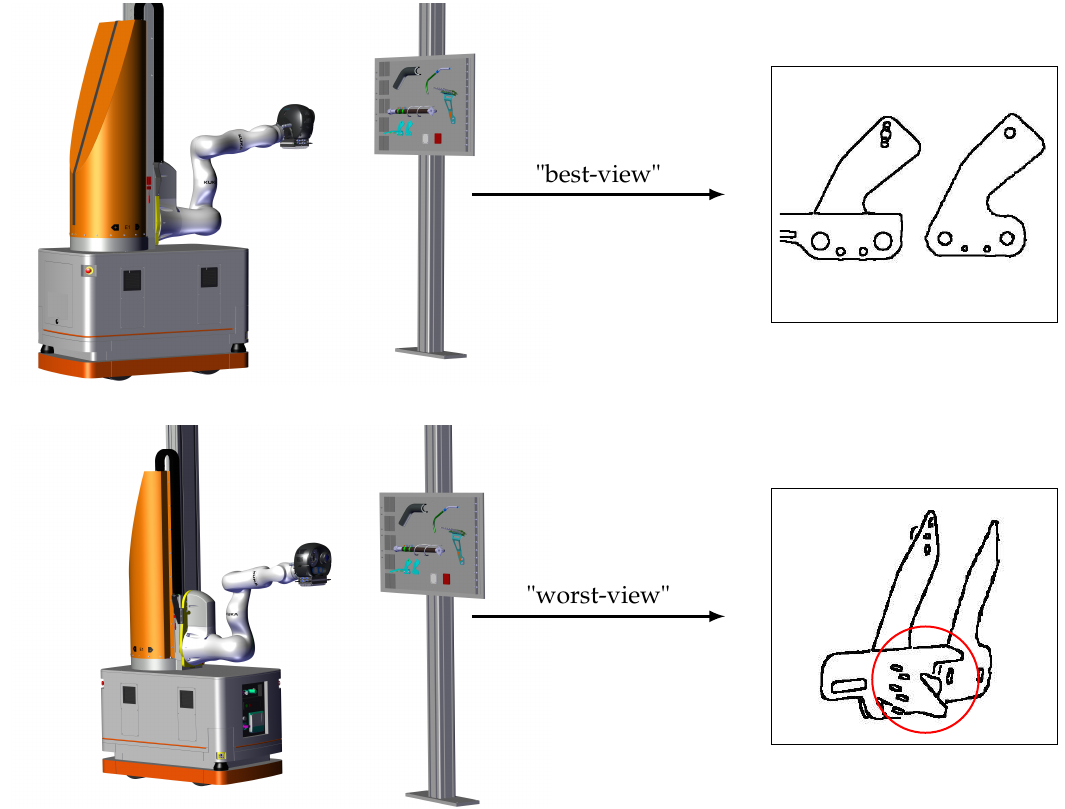
Figure 22. Two viewpoints with best-view and worst-view according to the number of parasite